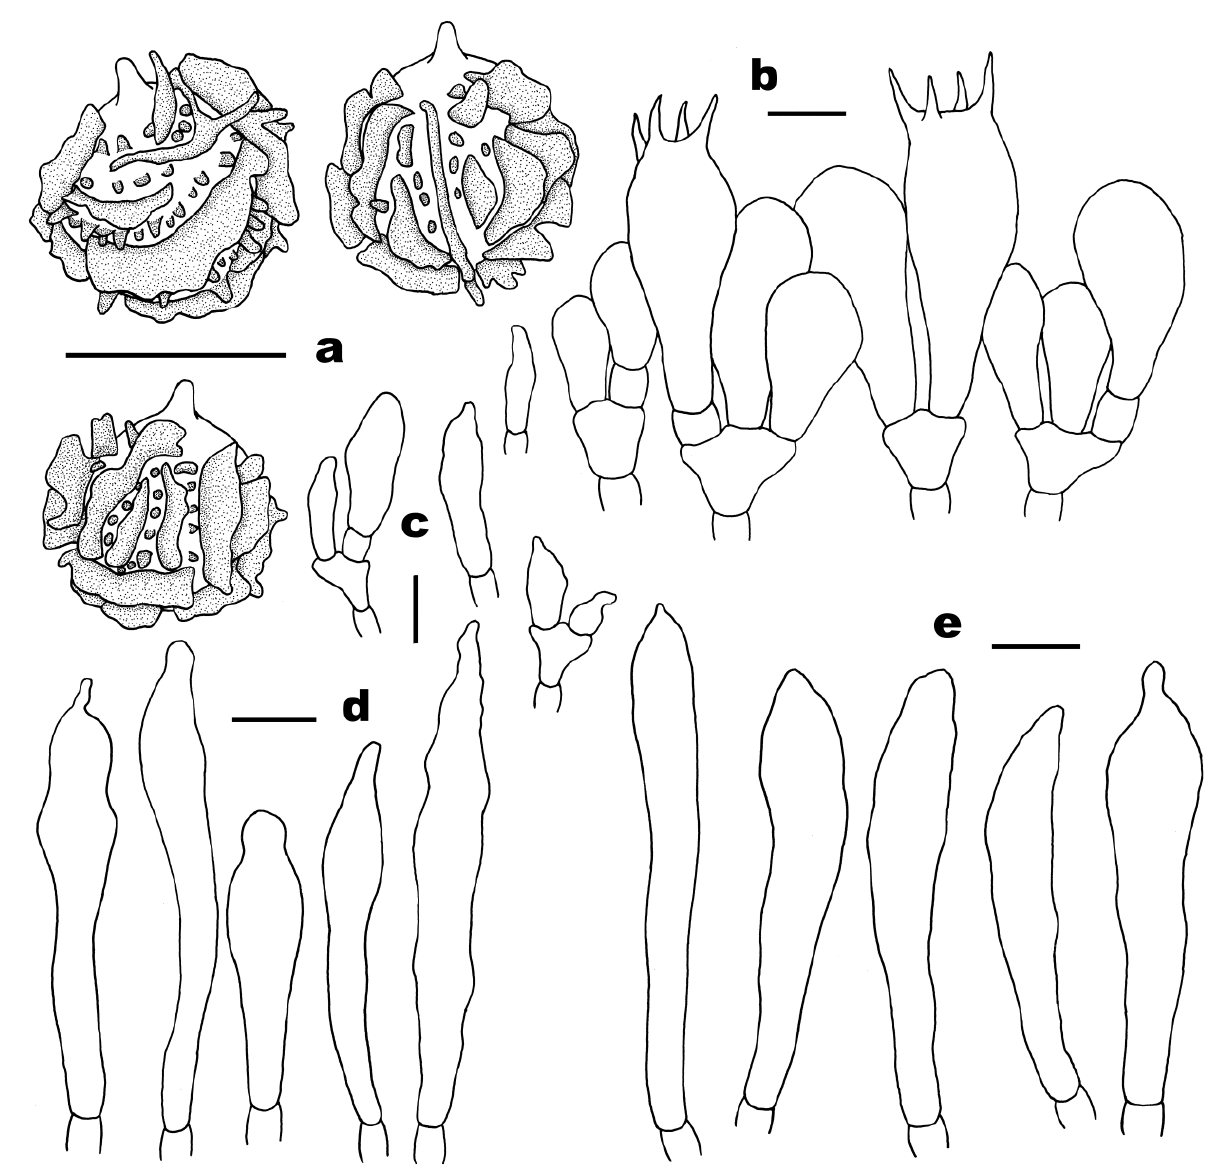
Figure 4. Microscopic features of Russula fujianensis (FHMU975, holotype). ( a ) Basidiospores. ( b ) Basidia and basidiola. ( c ) Marginal cells. ( d ) Pleurocystidia. ( e ) Cheilocystidia. Bars: 10 µ m. Drawings by Y.X. Han.